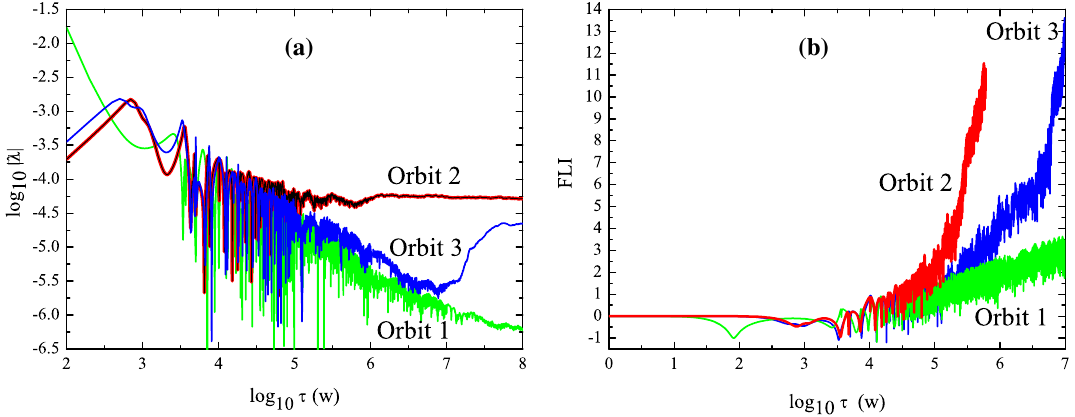
Fig. 4 a Lyapunov exponents of three orbits including Orbits 1 and 2 in Fig. 1 and Orbit 3 in Fig. 2d. The Lyapunov exponent (colored red) of Orbit 2 calculated in the new coordinate time w coincides with that (colored black) of Orbit 2 computed in the proper time τ . Orbit 1 is regular, whereas Orbits 2 and 3 show the onset of chaos. b Fast Lya- punov indicators (FLIs) of the three orbits. The FLI of Orbit 2 reaches w = 10 8 . Compared with the method of Lyapunov expo- nents, the fast Lyapunov indicator (FLI) of Froeschlé and Lega [31] is based on computations of tangent vectors and